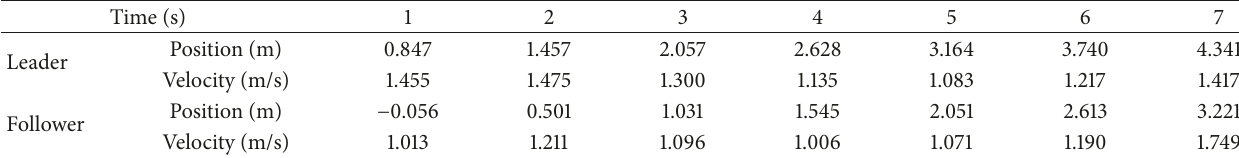
Table 1: Position and velocity time-series